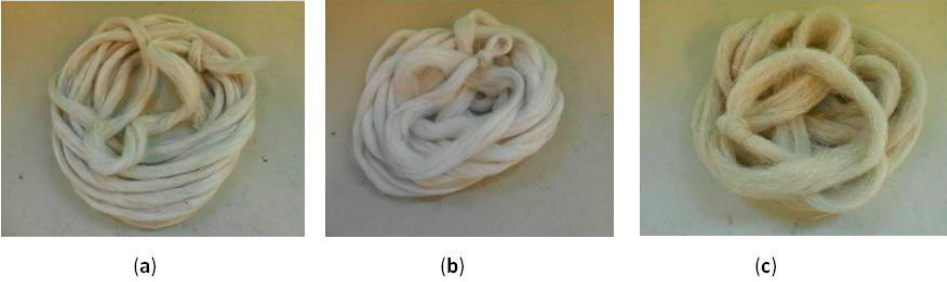
Figure 8. Drawing sliver of the banana fiber blended with: ( a ) cotton; ( b ) polyester; ( c ) wool.